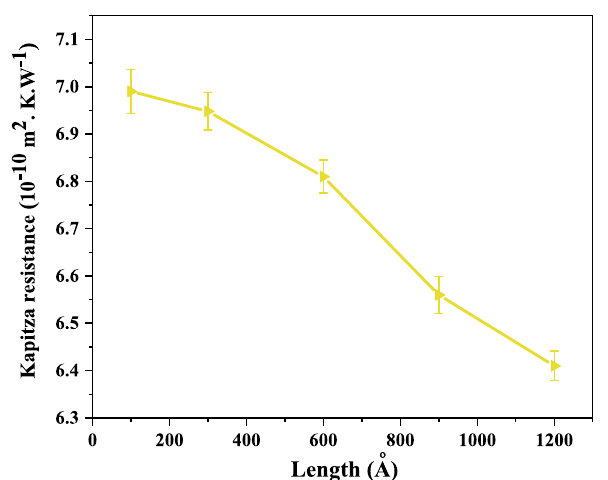
Figure 10. The changes in Kapitza thermal resistance of constructed grain boundaries A 6 (5–7–5–7–a) in BC 3 GrHs function of nanosheet length at ΔT = 40 K and T = 300